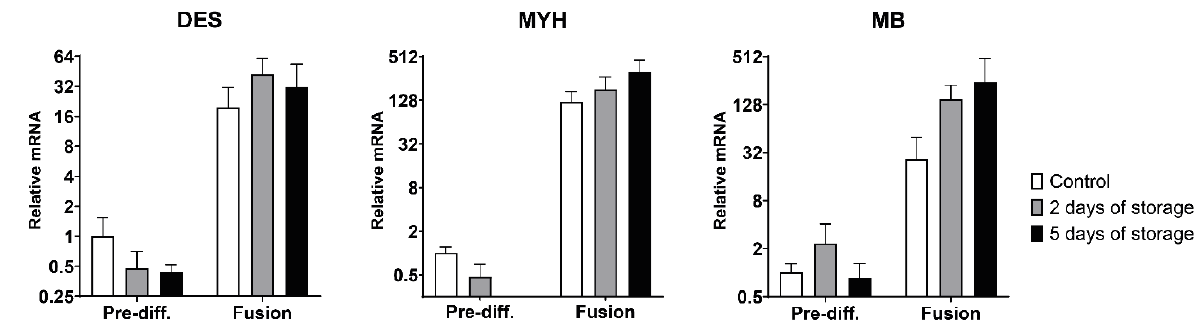
Figure 5. Quantitative RT-PCR analysis of muscle-specific gene expression before and after fusion. Relative mRNA expression of the muscle-specific genes: DES (desmin), MYH (myosin heavy chain) and MB (myoglobin) in pre-differentiated (Pre-diff.) satellite cells and after fusion. The data is presented as relative mRNA levels (relative to pre-differentiated control samples). The Y-axis is log2 scaled. The data is presented as mean ±SEM based on three cows ( n = 3), except for the 5 days of storage data which is from only two cows (n = 2). MYH Pre-diff. data from 5 days of storage was omitted as it was only detected in one cow.